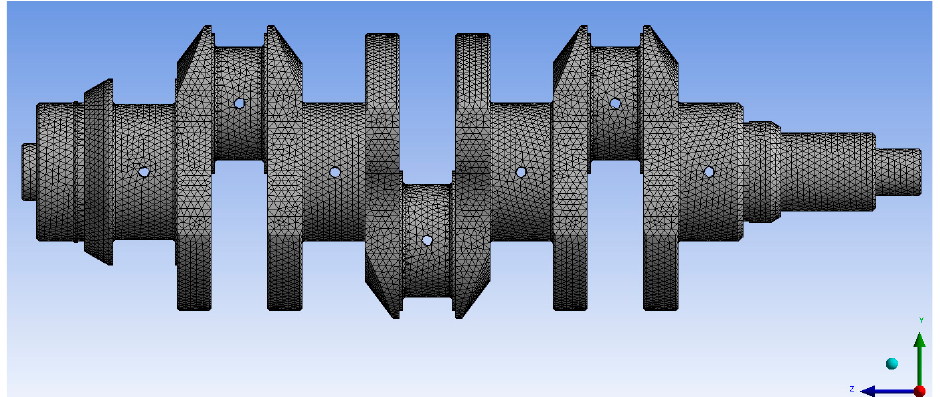
Figure 3. Grid independence test.